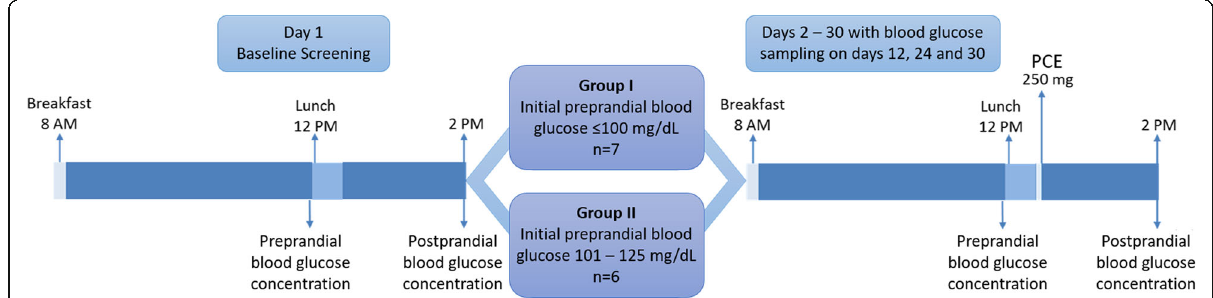
Fig. 1 Pilot study design. We measured preprandial blood glucose4 h after breakfast. During the time-period between breakfast and lunch, we instructed volunteers to refrain from consuming any food or beverage, except water, which was provided ad libitum . Lunch consisted of a typical south Indian meal of rice, vegetable curry with meat or fish to be consumed within 30 m. We measured postprandial glucose 2 h after the start of lunch. On the initial day of the study (Day 1), volunteers followed this routine and we categorized the patients into two groups according to their preprandial glucose levels. Then, for the next 30 days, volunteers consumed PCE (250 mg) 5 min after lunch. We assessed blood glucose on